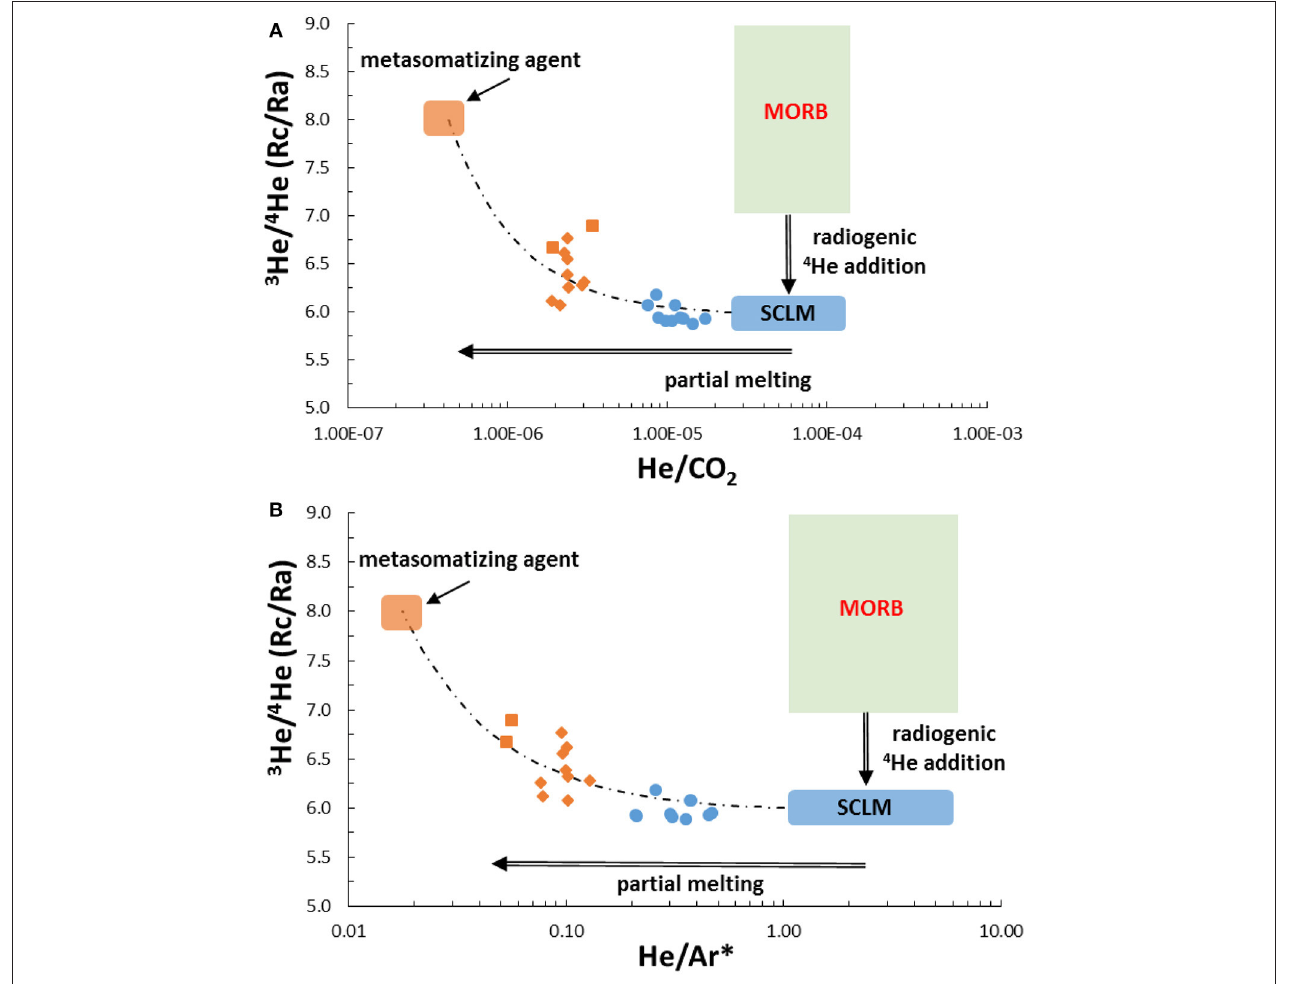
FIGURE 10 | He/CO 2 and He/Ar* vs. 3 He/ 4 He corrected for air contamination (Rc/Ra values). The green, blue, and orange rectangles are the same as in Figure 7 . The black dotted line represents binary mixing between two endmembers: (1) the residual mantle (blue rectangle) having He/CO 2 = 2.5 × 10 − 5 , He/Ar* = 1, and − 7 , He/Ar* = 1.7 × 10 − 2 , and 3 He/ 4 He = 8 Ra. The symbols are the 3 He/ 4 He = 6 Ra, and (2) the metasomatic agent (orange rectangle) having He/CO 2 = 3.7 × 10 same as in Figure 5